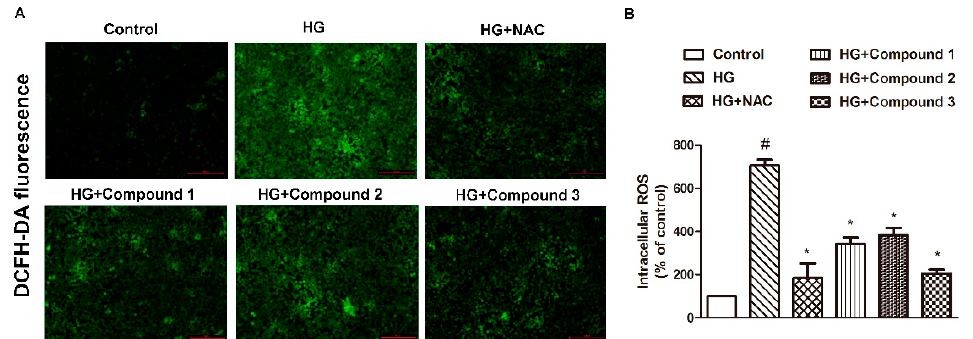
Figure 5. ( A ) Compounds 1 , 2 , and 3 inhibited high glucose (HG)-induced reactive oxygen species (ROS) production. The HUVECs were pretreated with 1 , 2 , and 3 (80 µM) for 12 h or with NAC (N-acetyl-L-cysteine, 500 µM) for 1 h before 35 mM HG incubation for another 24 h. ( A ) Intracellular levels of ROS were detected by 2‘,7‘-dichlorofluorescein diacetate (DCFH-DA) fluorescence (×200). ( B ) Intracellular ROS fluorescence values. The NAC group is a positive control group. Values are mean ± SD. # p < 0.05 vs. control, * p < 0.05 vs. HG, n = 3 /